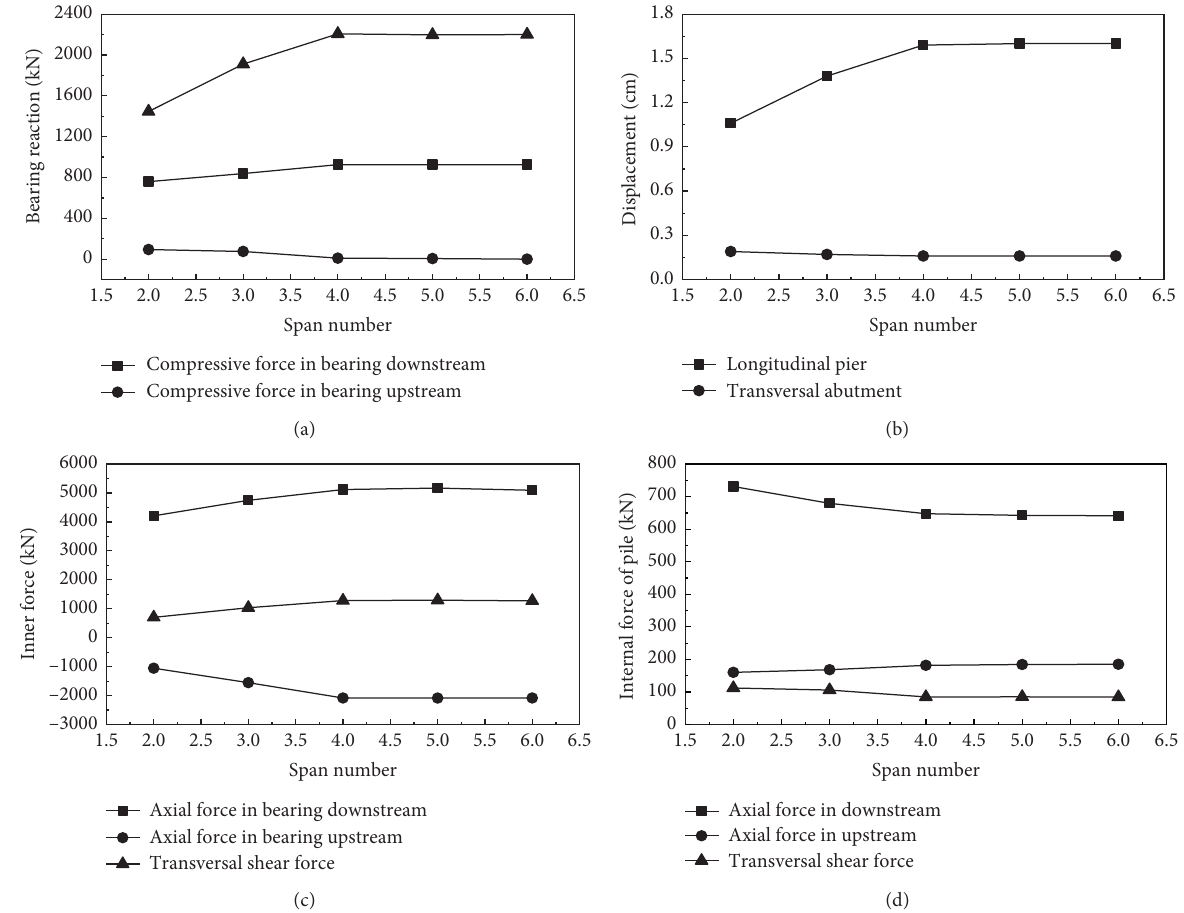
Figure 22: Variation of inner forces of structure and deflections with different numbers of spans. (a) Vertical force in bearings. (b) Displacement. (c) Internal force in piers. (d) Internal force in